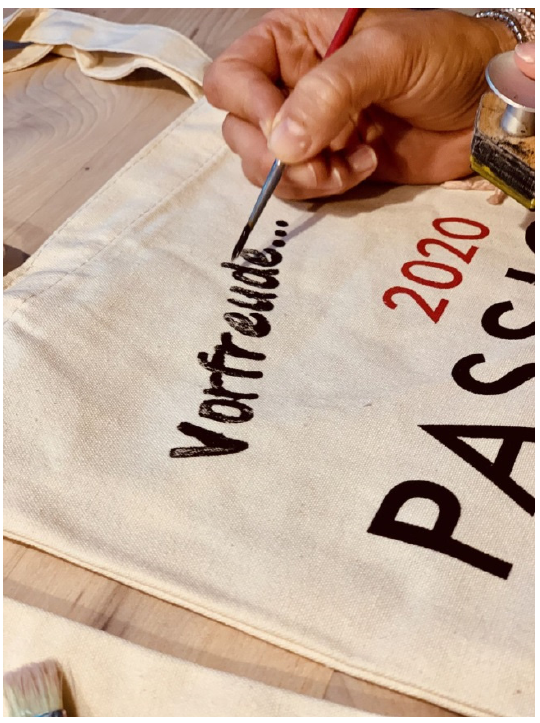
Figure 5. ‘Anticipation’: reprint of an Oberammergau merchandise bag (https://www.passionsspiele-oberammergau.de/de/blog/detail/was-die-passionsspiele-mit-snowboarden-zu-tun-haben-2020 0614, accessed on 8 January